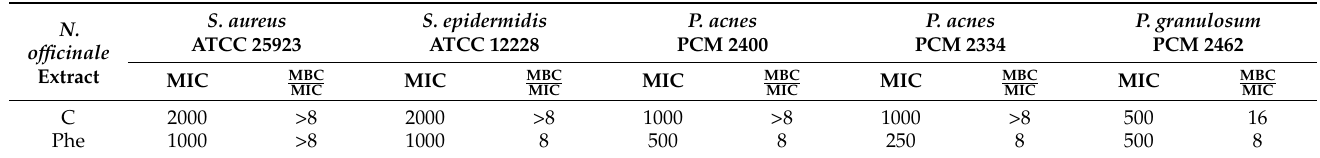
Table 8. Minimum inhibitory concentration (MIC, µ g/mL) and ratio of minimum bactericidal concentration to MIC (MBC/MIC) of extracts from bioreactor-grown N. officinale microshoot cultures ( p < 0.05 vs. control, n = 3). N. officinale